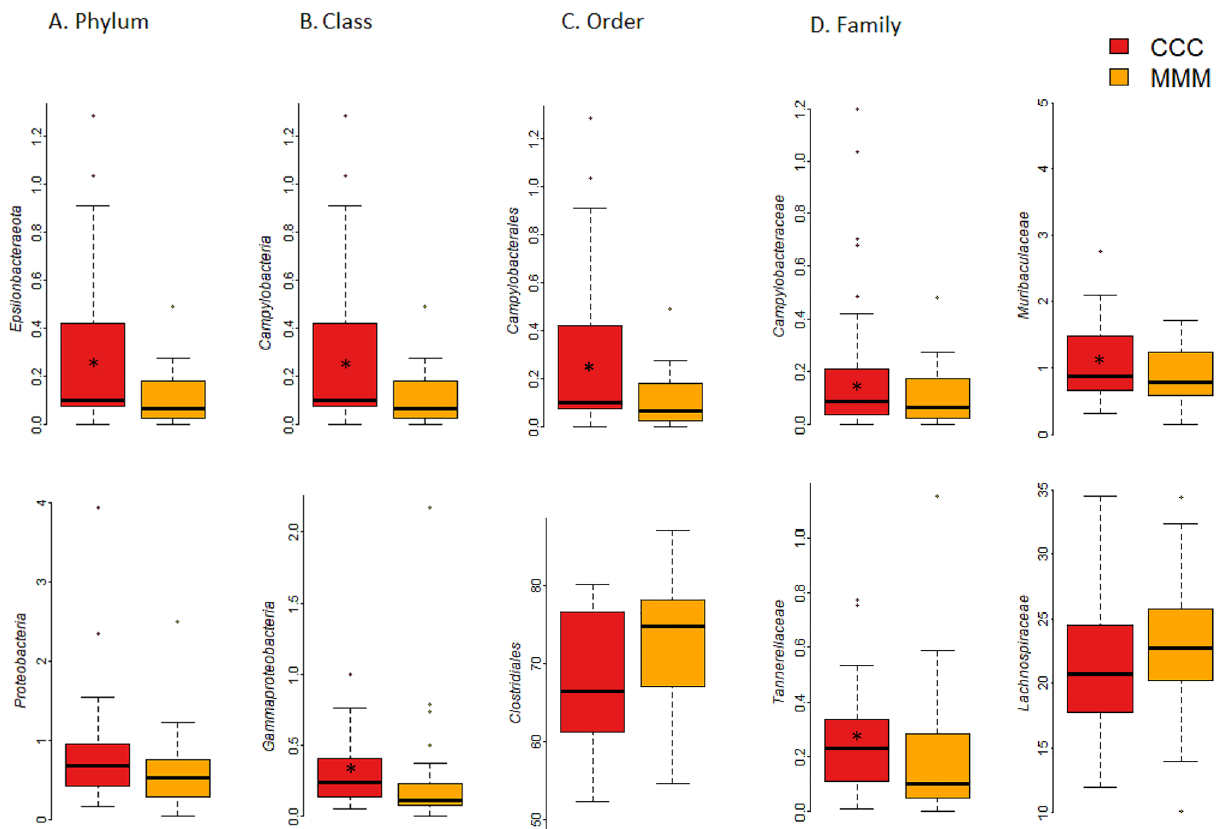
Figure 4. Relative abundances of microbiota between control (CCC), and MFC (MMM) piglet groups at different taxa. ( A ) Phylum, ( B ) Class, ( C ) Order, ( D ) Family. Asterisks indicate significant differences (p <